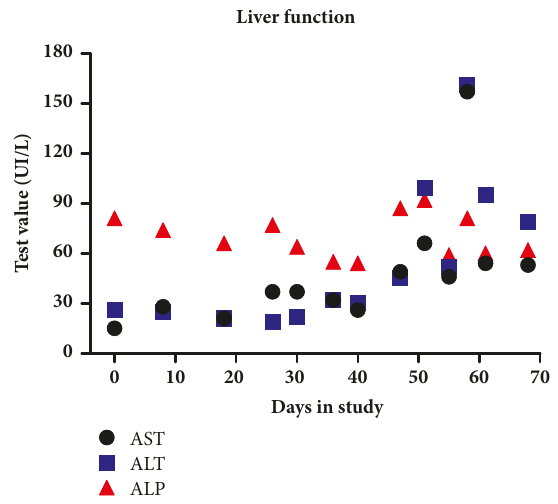
Figure 2: Values of liver enzymes over time. Clinical chemistry indicated that liver enzymes (AST, ALT, and ALP) were within normal limits during the entire study except on day 58 when AST and ALT were temporarily elevated and over the upper limit (AST was 157 IU/L with a REF range of 15-66IU/L; ALT was 161 IU/L with a REF range of 12-118 IU/L). All three liver enzymes returned to normal range by day 68.